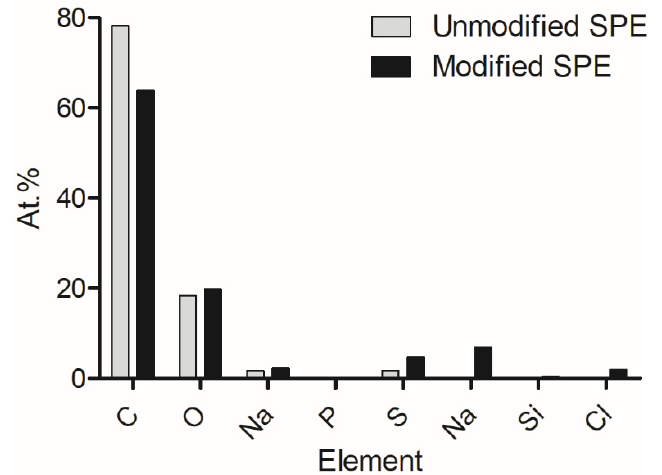
Figure 1. Changes in elemental composition which occurred on the electrode as a result of electrode modification [40].